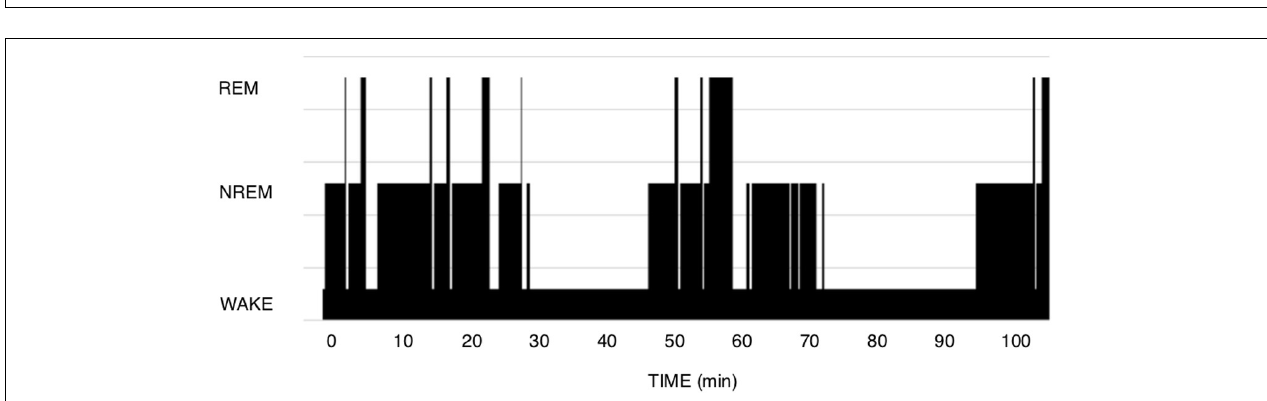
FIGURE 1 | Human polysomnogram. Healthy male, 35 years. It is intuitive here to think in terms of cycles, since about the same NREM duration precedes the 5 presented REM sleep episodes. It could be interesting to exercise the eye to see them differently, as PRRP with a null Lambda and immediate return to NREM sleep.